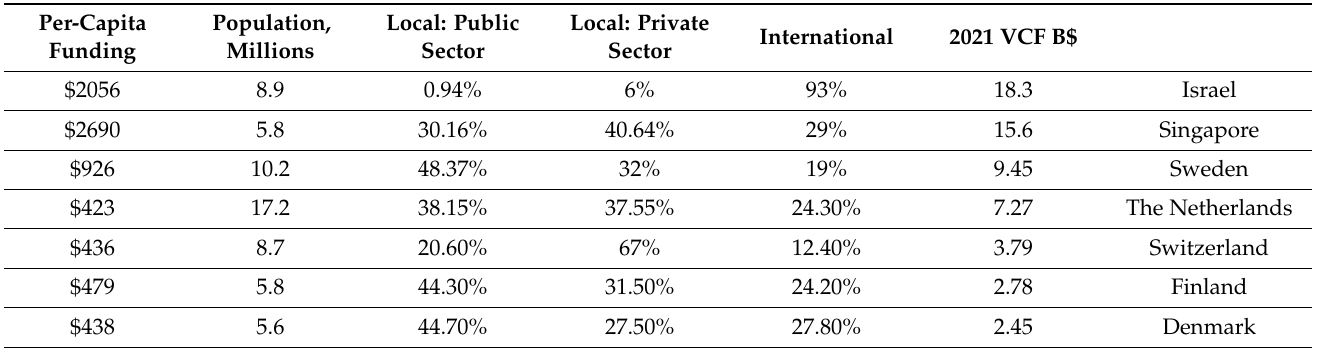
Table 1. Absolute and per-capita VCF activities in selected